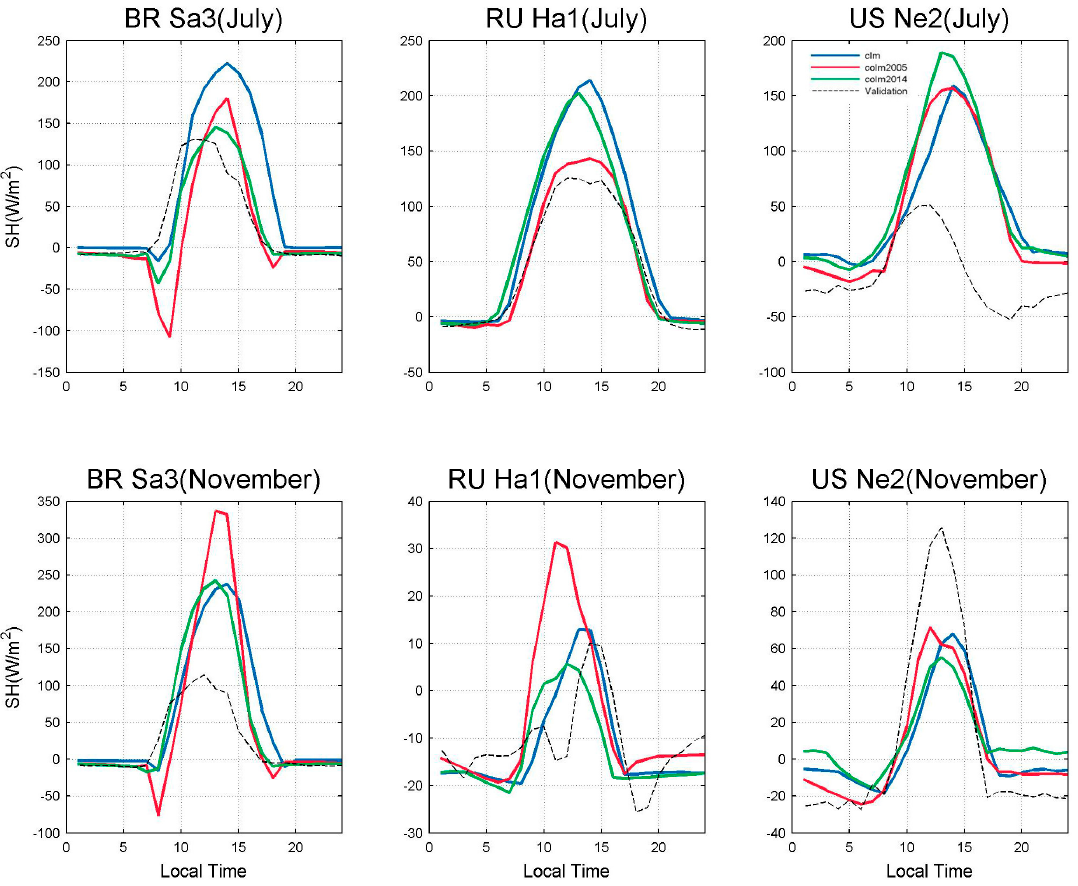
Figure 14. Same as Figure 11, but for sensible heat flux (Units: W m − 2 ).